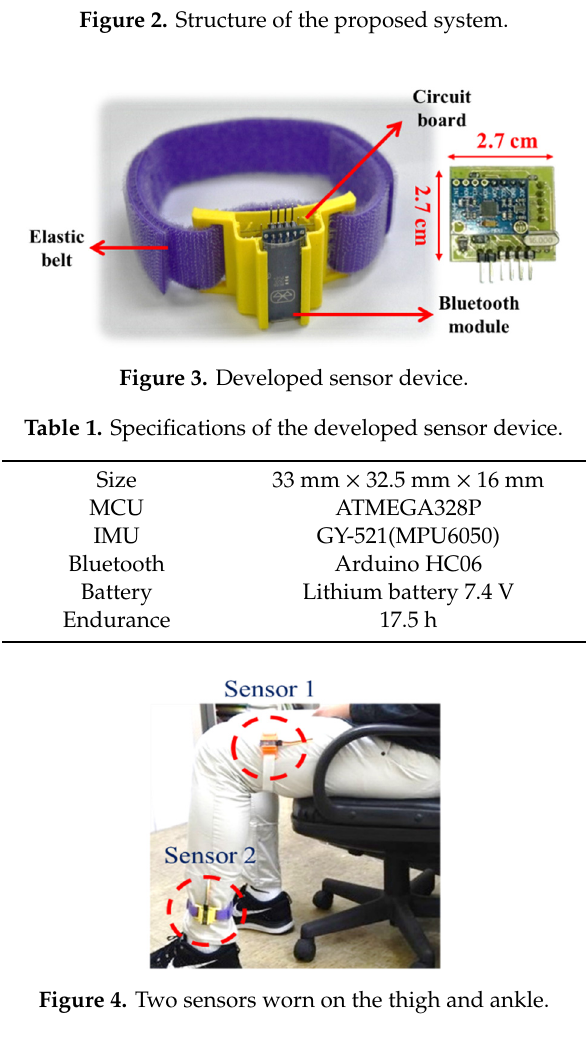
Figure 4. Two sensors worn on the thigh and ankle. Table 1. Specifications of the developed sensor device.